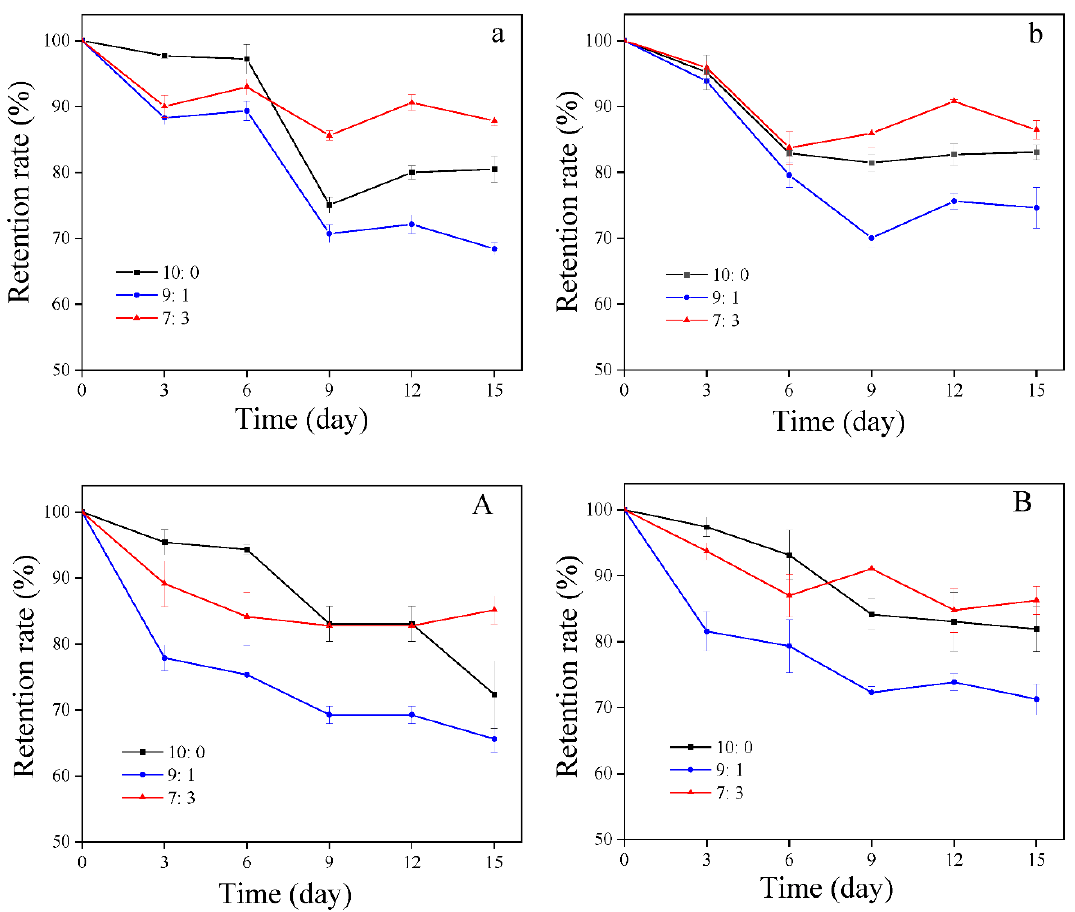
Figure 5. Retention rate of WP-OS-capsaicin microcapsules under different storage conditions (( a ), 50 °C in the dark; ( b ), 25 °C in the dark; ( A ), 25 °C in the UV light; ( B ), 25 °C in the lightness). 10:0, 9:1, and 7:3 represent WP (whey protein):OS (OSA-modified starch). Error bars represent standard deviation.